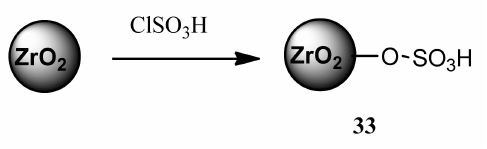
Figure 12. Sulfonic acid-functionalized ZrO 2 from ref [70].